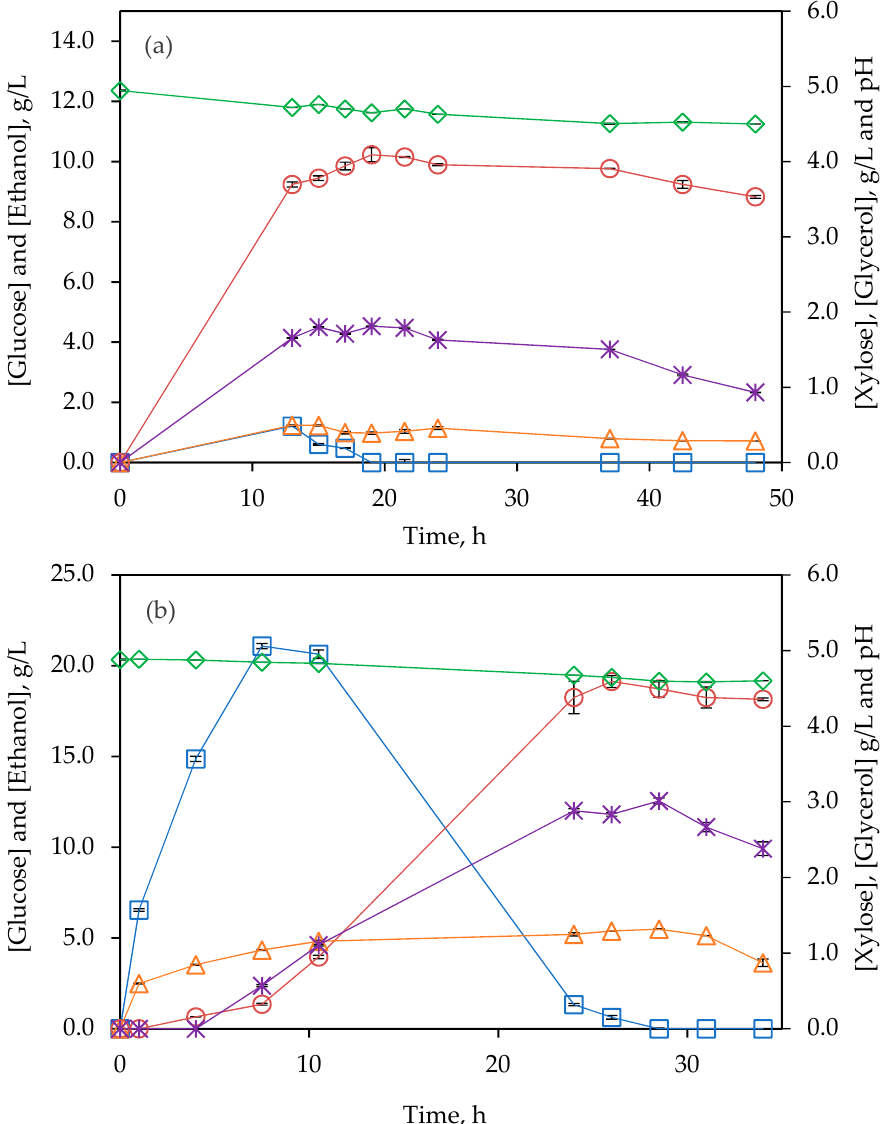
Figure 6. Evolution of ◇ pH and □ glucose, △ xylose, ○ ethanol and ∗ glycerol concentrations for fermentation from subW-pretreated BSG ( a ) 8% ( w/v ) and ( b ) 15% ( w/v ) in a SSF configuration. Analytical measurements were conducted in triplicate.